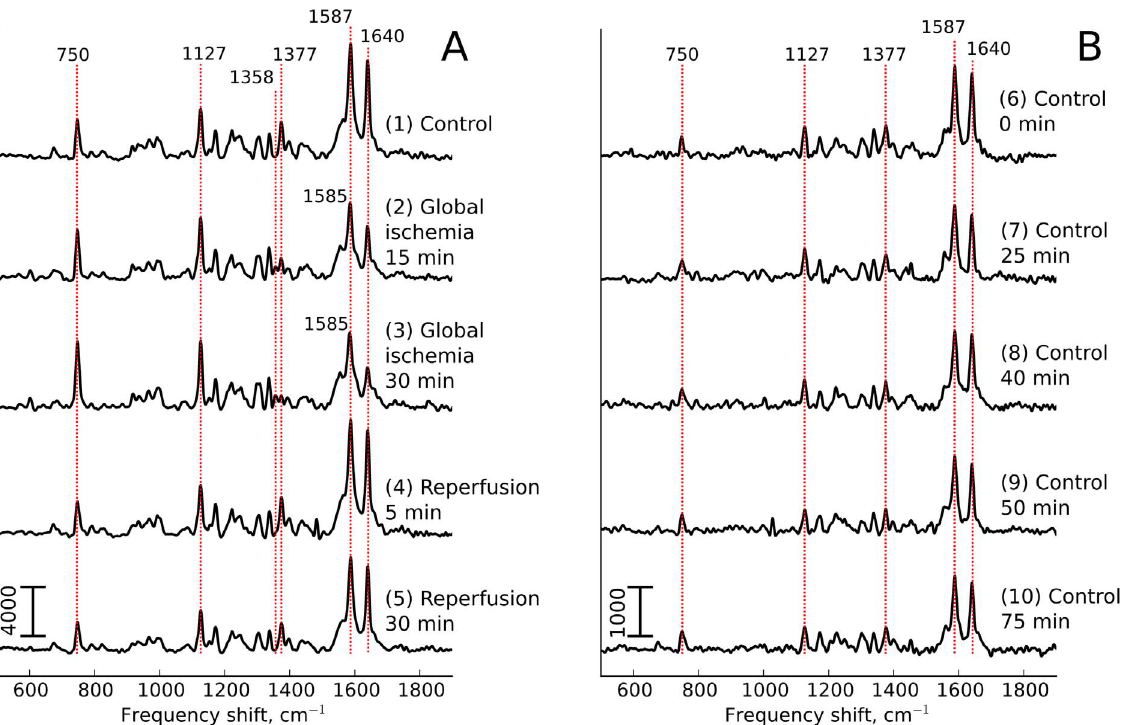
Figure 4. Experiment on global ischemia. (A): Raman spectra of the isolated heart under global stop-flow ischemia. (B) Raman spectra of the control heart continuously perfused during the time interval equaled to the duration of global ischemia experiment. Registration time points in control experiment correspond to the registration time points in global ischemia experiment.